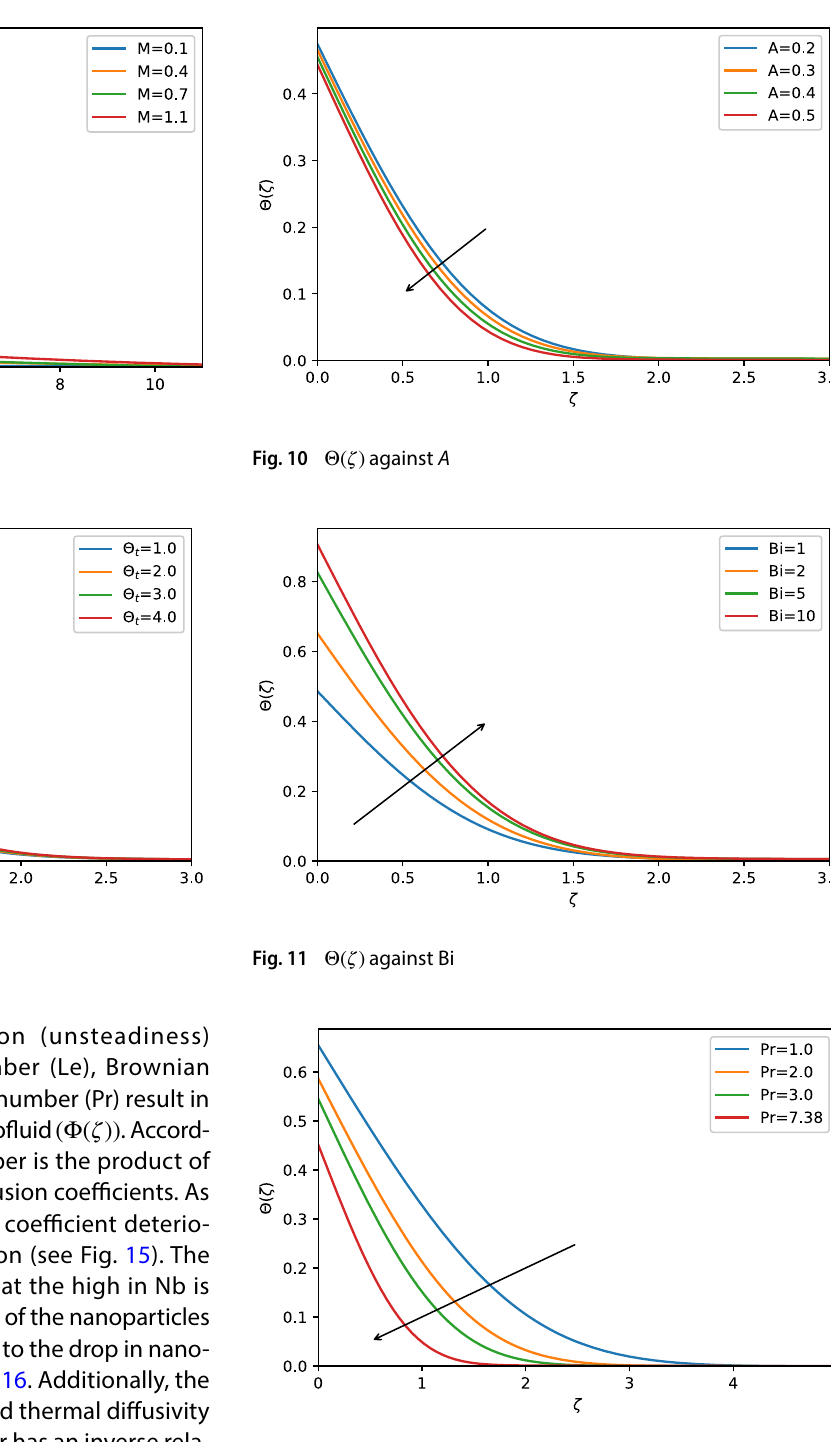
Fig. 12 Θ( 𝜁 ) against